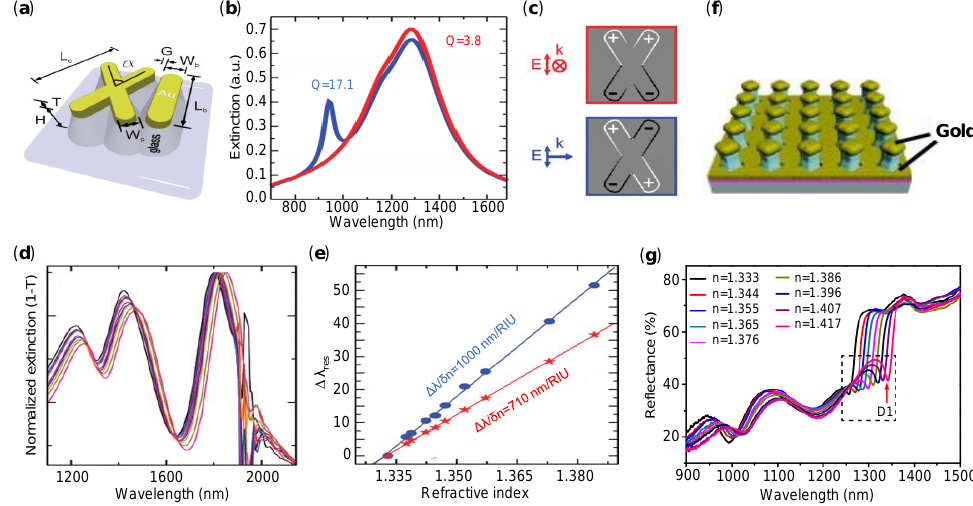
Figure 6. Plasmonic sensors based on Fano resonances. ( a ) Schematic of the nanocross cavity. ( b ) Calculated extinction spectra for a nanocross structure illuminated by a vertically polarized plane wave from normal (red curve) and grazing (blue curve) incidence. ( c ) Calculated charge density distribution of the dipole (top) and quadrupole mode (bottom). ( d ) RI sensing spectral response for the XI-cavity. ( e ) Spectral shift depending on the surrounding liquid for the subradiant bonding dipole-dipole mode (blue curve) and bonding quadrupole-dipole Fano resonance (red curve), respectively. ( f ) Schematic of array gold mushroom structures. ( g ) Reflectance spectra of the structure from ( f ) immersed in glycerine water mixture solutions with varying RI. Reprinted ( a – e ) with permission from Reference [110]. Reprinted ( f , g ) with permission from Reference